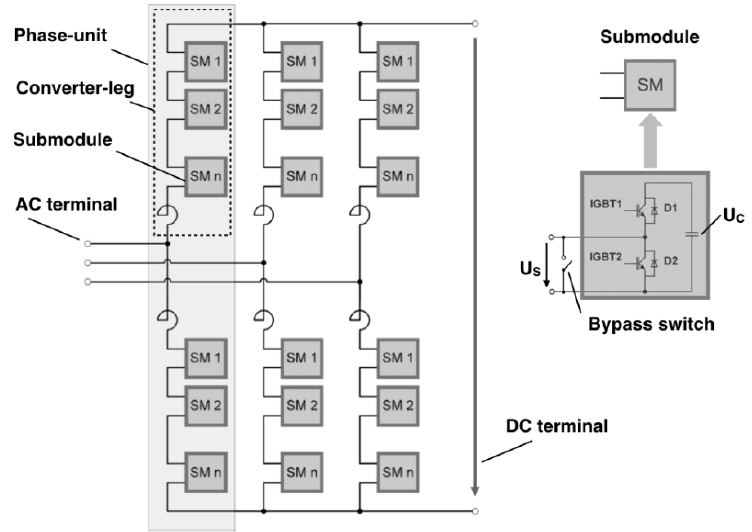
Figure 3. Schematic configuration of the three phase modular multilevel converter (MMC) and structure of the half bridge submodule (SM).